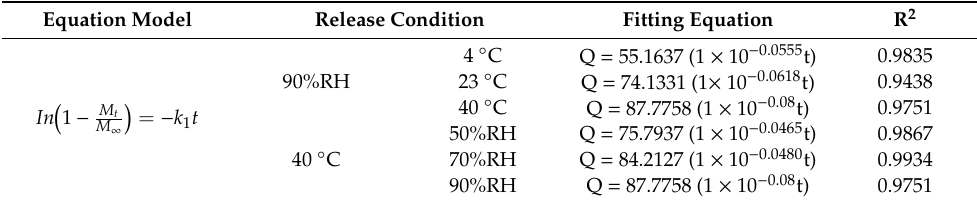
Table 1. Fitting results for first-order model of SiO 2 -CA microcapsules.